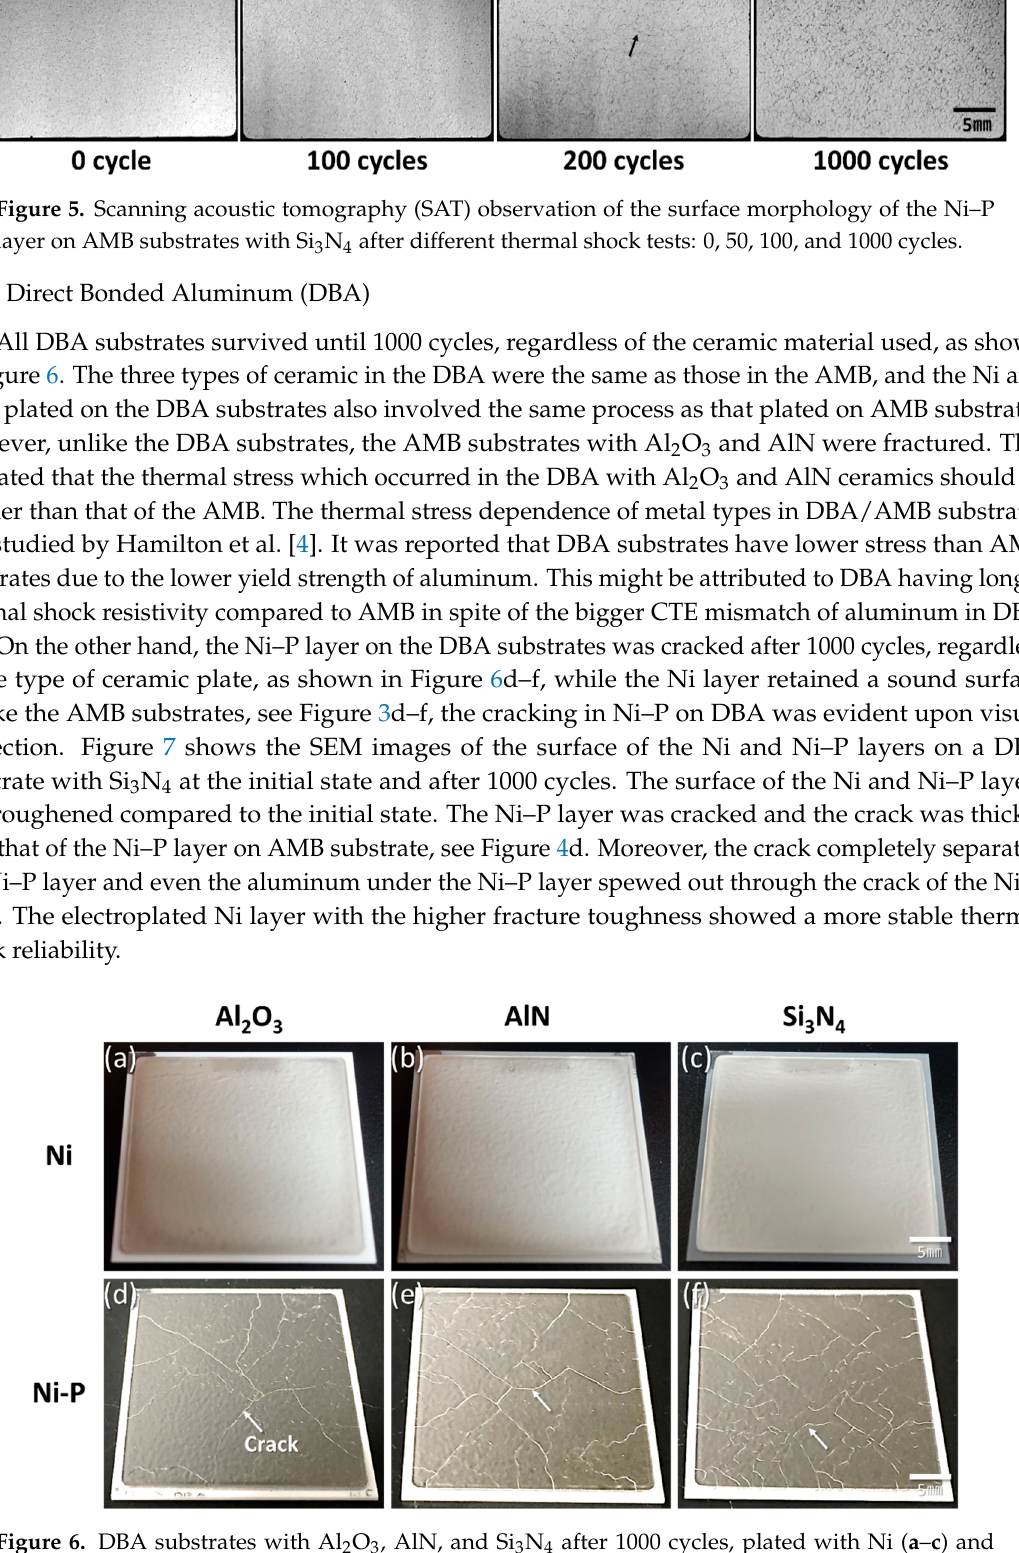
Figure 4. Surface variation of Ni ( a , b ) and Ni–P ( c , d ) layers on AMB substrates with Si 3 N 4 before and after 1000 cycles.